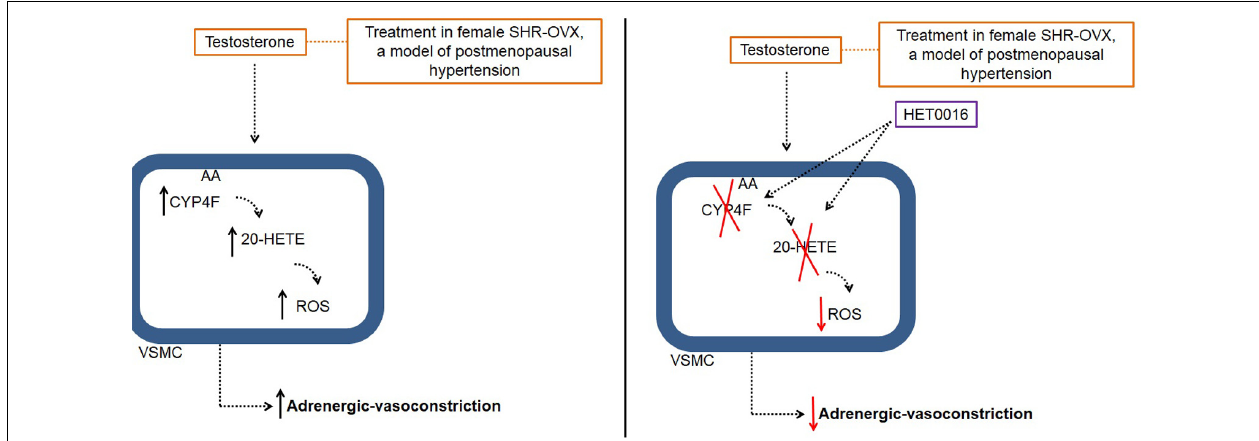
FIGURE 7 | Illustrative image of testosterone effects in aorta of ovariectomized (OVX) Spontaneously Hypertensive Rat (SHR), a model of postmenopausal hypertension. AA: acid arachidonic; 20-HETE: 20-hydroxyeicosatetraenoic acid; HET0016: N -hydroxy- N (cid:48) -(4-n-butyl-2-methylphenyl)Formamidine; ROS, reactive oxygen species; VSMC, vascular smooth muscle